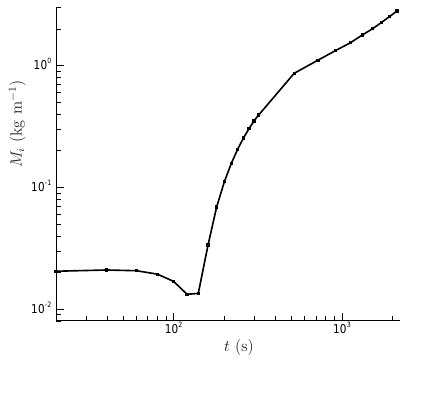
Fig. 18. Time evolution of the total ice mass per meter of flight